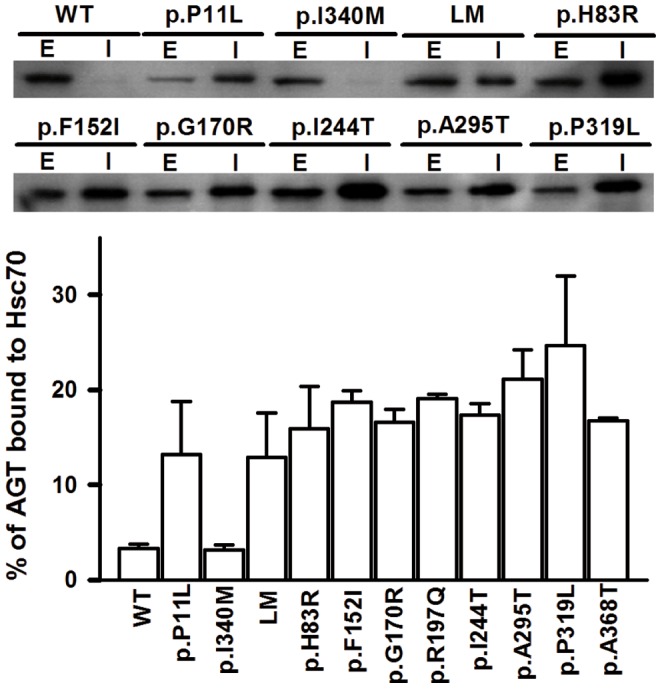
Interaction of AGT variants with Hsc70 chaperones in a cell-free system.Representative autoradiograms of AGT proteins labeled with 35S-Met are shown for several AGT variants (E: total AGT synthesized in extracts; I: AGT immunoprecipitated using anti-Hsc70 antibodies; note that 1 µl of the TnT reaction was loaded in E lanes, while the protein immunoprecipitated from 6 µl TnT lysate was loaded in I lanes). Data in the lower panel are expressed as percentage of immunoprecipitated AGT compared to the total AGT synthesized, and are mean±s.d. from three independent experiments.